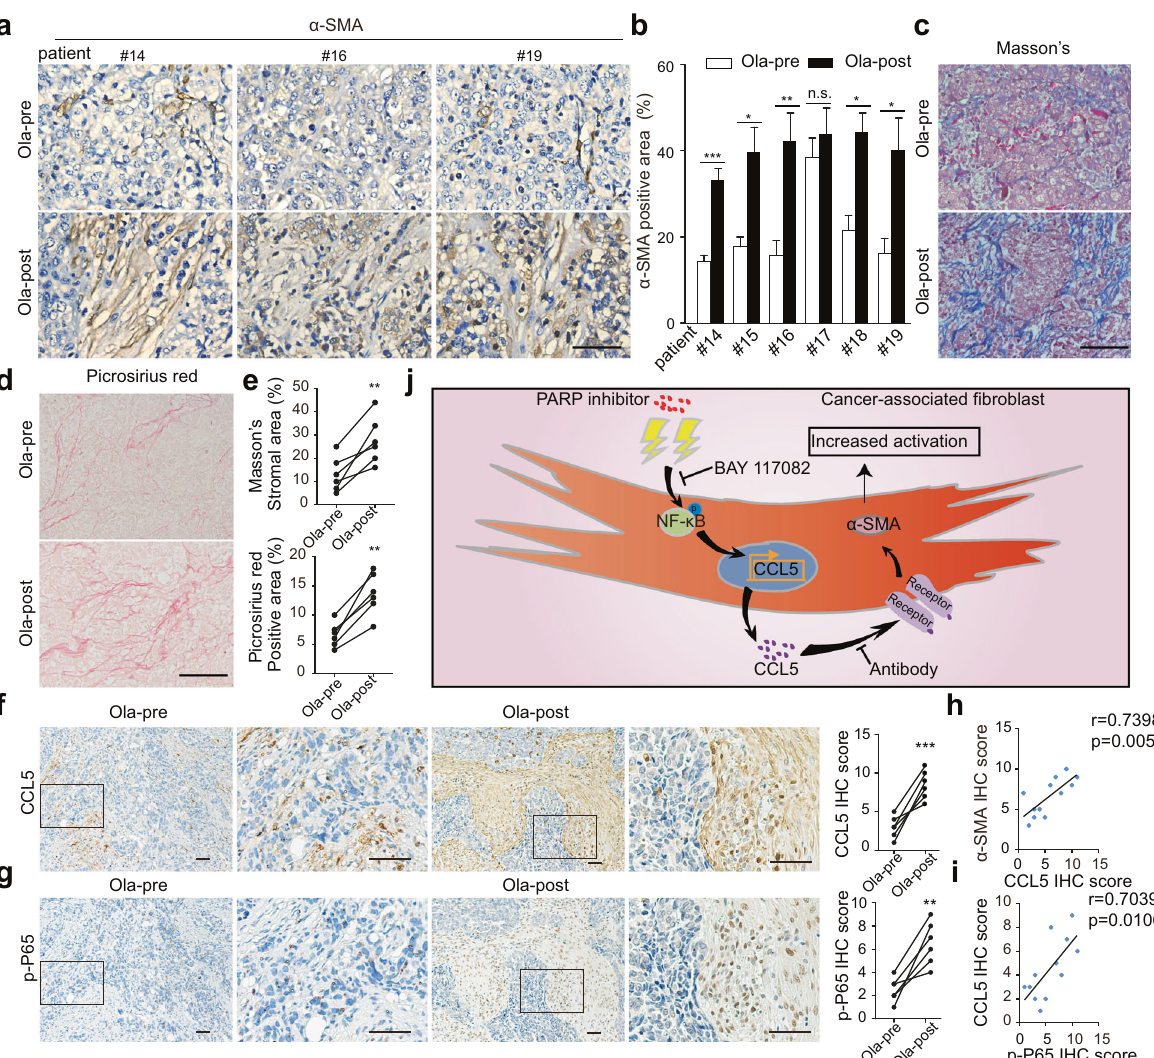
Fig. 7 Olaparib induces stromal fi broblast activation in human OC tumor specimens. a Immunohistochemical detection of α -SMA in matched tumor specimens from patients with OC before and after administration with Ola. Scale bar, 50 µm. b Quanti fi cation of α -SMA- positive areas in tumor specimens from OC patients. Same images were measured repeatedly. c – e Representative images and quanti fi cation of Masson ’ s trichrome and picrosirius red staining showing that Ola administration increased the content of stromal components and collagen deposition in human OC tumor specimens. Scale bar, 50 µm. Same images were measured repeatedly. f , g Representative IHC images and quanti fi cation of CCL5 and p-P65 in matched tumor specimens from patients with OC before and after administration with Ola. Scale bar, 50 µm. Measures were taken from different samples ( n = 6). h Correlation analysis of CCL5 IHC scores and α -SMA IHC scores in matched tumor specimens from patients with OC before and after administration with Ola. i Correlation analysis of p-P65 IHC scores and CCL5 IHC scores in matched tumor specimens from patients with OC before and after administration with Ola. j Schematic representation of the effect of PARPis on human ovarian stromal fi broblasts. Data are expressed as mean ± s.e.m., * p < 0.05; ** p < 0.01; *** p <